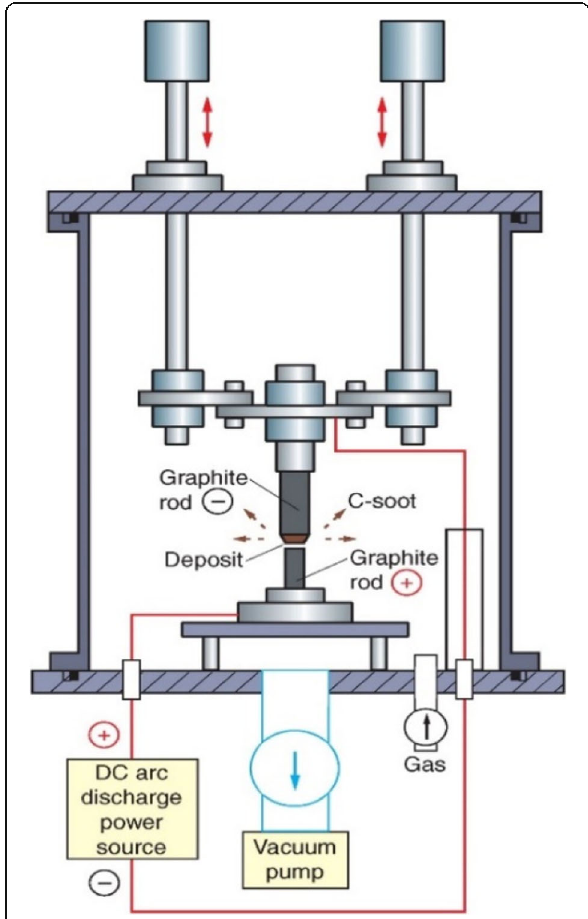
Fig. 5 Schematic diagram of an arc-discharge system used to synthesize CNTs. In this technique, nanotubes are produced on one of the graphite electrodes when a large arcing current flows inside a metal reactor maintained at high pressure and temperature. Adapted from [79]